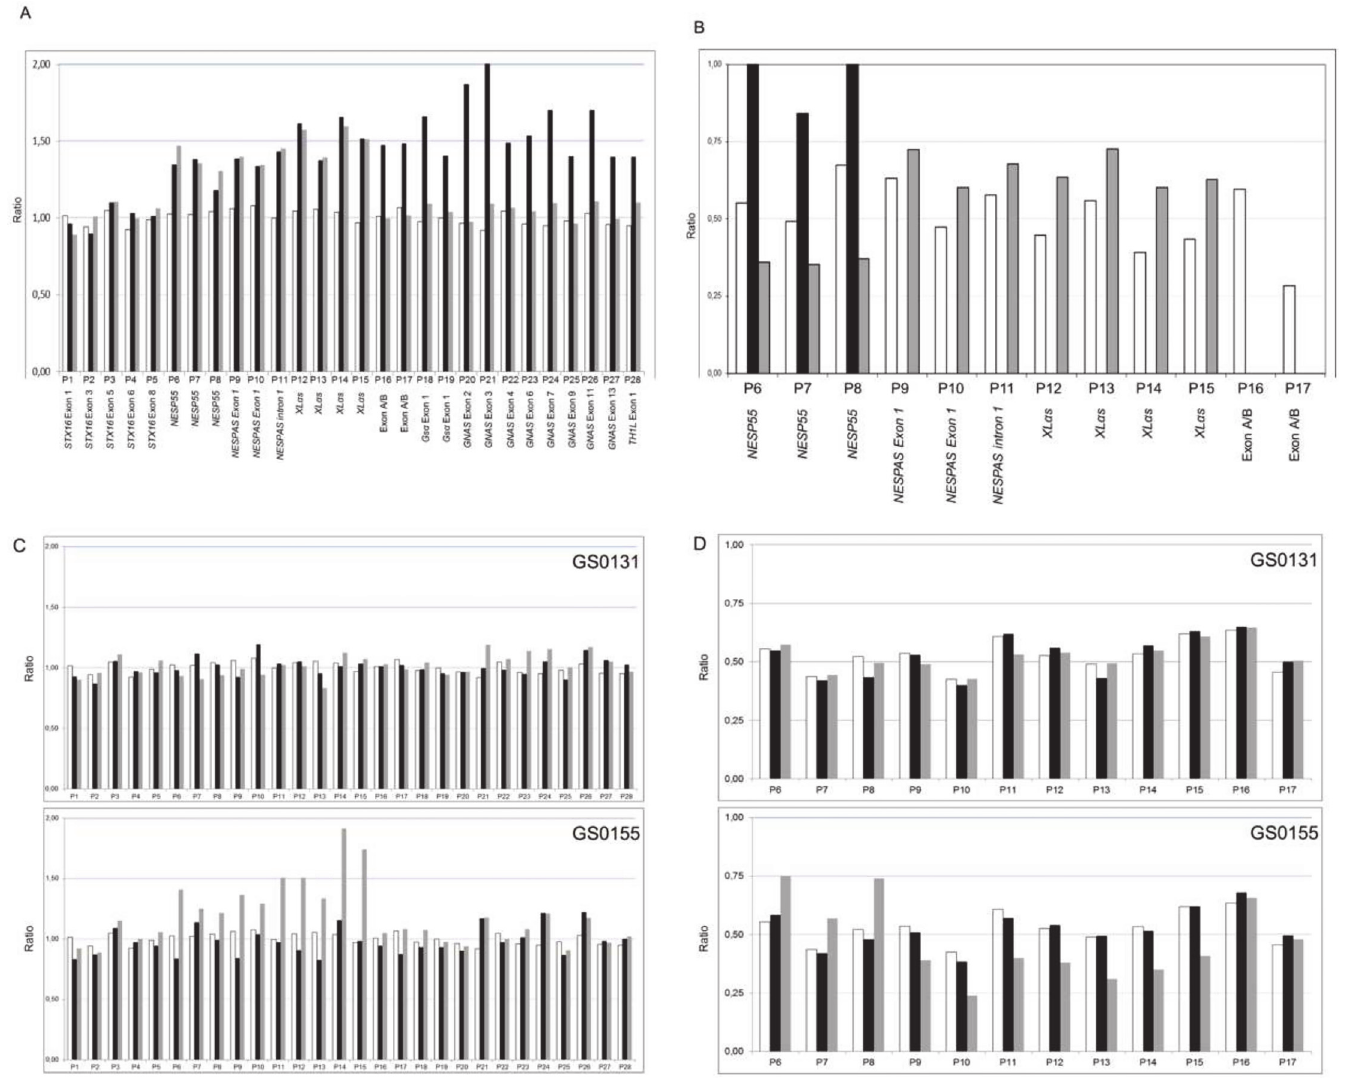
Fig 2. Dosage and methylation analysis of the GNAS locus. In all cases, on the X-axis, MS-MLPA probes for copy number determination (P1 to P28) or methylation analysis (P6 to P17) are shown according to their chromosome location (detailed in Table 1). On the Y-axis, the final probe ratio is shown. (A) Dosage analysis of the GNAS locus in GS0131 (black bars) and GS0155 (grey bars) compared against the average of four controls (white bars). (B) Methylation analysis of the GNAS locus in GS0131 (black bars) and GS0155 (grey bars) compared against the average of four controls (white bars). GS0131 shows complete loss of methylation at NESPAS, XL α s and exon A/B, and gain of methylation at NESP55, whereas GS0155 shows complete loss of methylation at A/B, partial gain at XL α s and NESPAS and partial loss at NESP55. (C) Dosage analysis of the GNAS locus in GS0131 parents (upper panel) and GS0155 parents (lower panel) compared against the average of four controls. In all cases, black bars represent the father, grey bars represent the mother and white bars represent the controls. Mother of GS0155 presents the same duplication as her daughter, whereas absence of alterations in GS0131 parents demonstrates its ‘ de novo ’ origin. (D) Methylation analysis of the GNAS locus in GS0131 parents (upper panel) and GS0155 parents (lower panel) compared against the average of four controls. In all cases, black bars represent the father, grey bars represent the mother and white bars represent the controls. There is not any methylation alteration in the parents of GS0131. Mother of GS0155 presents a partial loss of methylation in XL α s (P12-P15) and NESPAS (P9-P11), and a partial gain of methylation in NESP55 (P6-P8), exon A/B not being affected. See text for